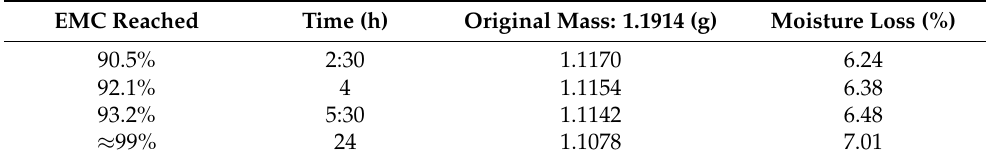
Table 2. Sample mass stability as a function of time and EMC.